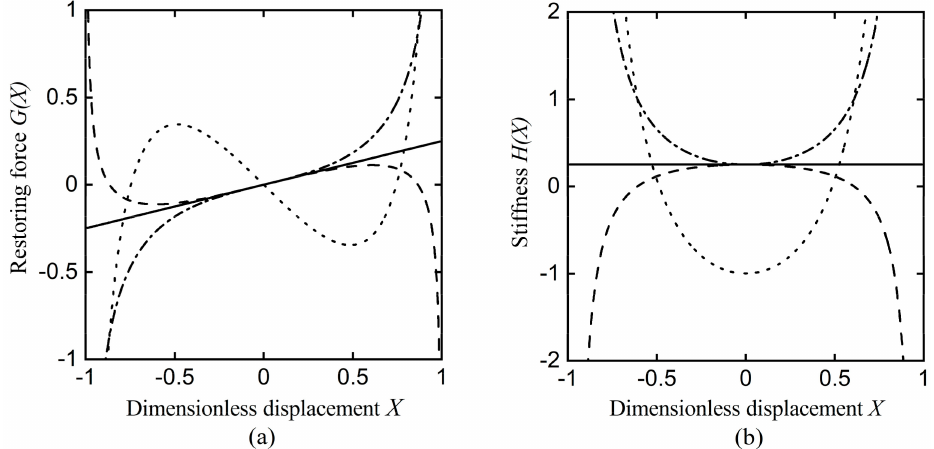
Figure 3. ( a ) Restoring force and ( b ) stiffness characteristics of the system. Solid, dashed, dash– dot, and dotted lines represent systems with ( α , β ) = ( − 1,0.75 ) , ( − 1.5,0.5 ) , ( − 0.5,1.5 ) , and ( − 0.4,5 ) ,